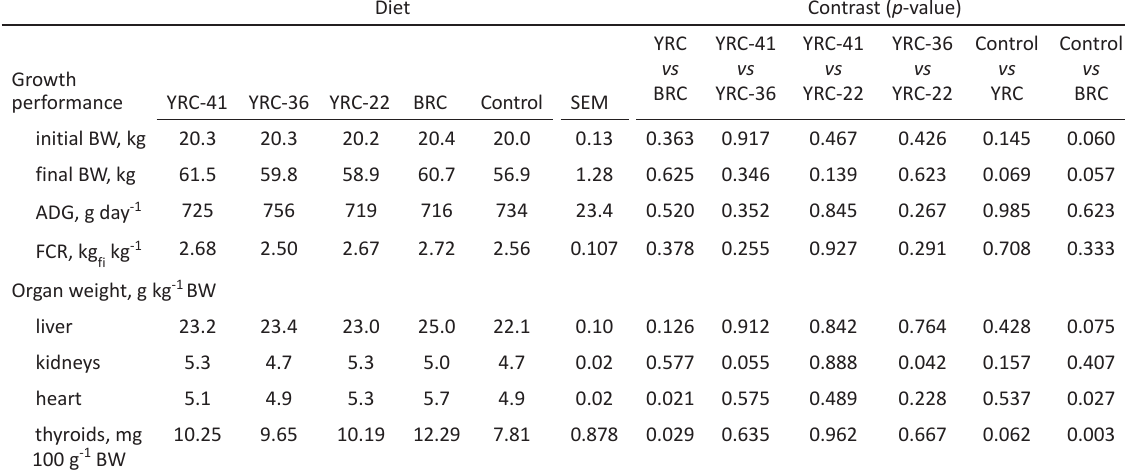
Table 7. Performance parameters and organ weights in pigs fed diets containing rapeseed cake or the control diet containing soyabean oil meal (Experiment 2)